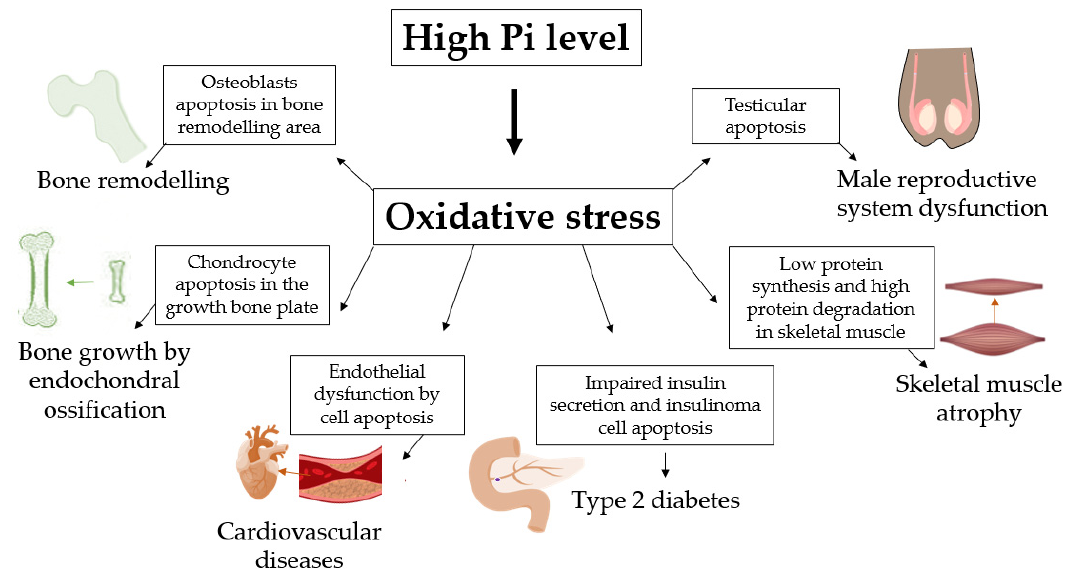
Figure 5. Oxidative stress high Pi-induced regulates physiological processes and disease development. High Pi level can induce oxidative stress and regulates bone remodeling [22–24], bone growth by endochondral ossification [28–31], cardiovascular diseases by atherosclerosis [40–46], type 2 diabetes [56,57], skeletal muscle atrophy [61] and male reproductive system dysfunction [59,60].